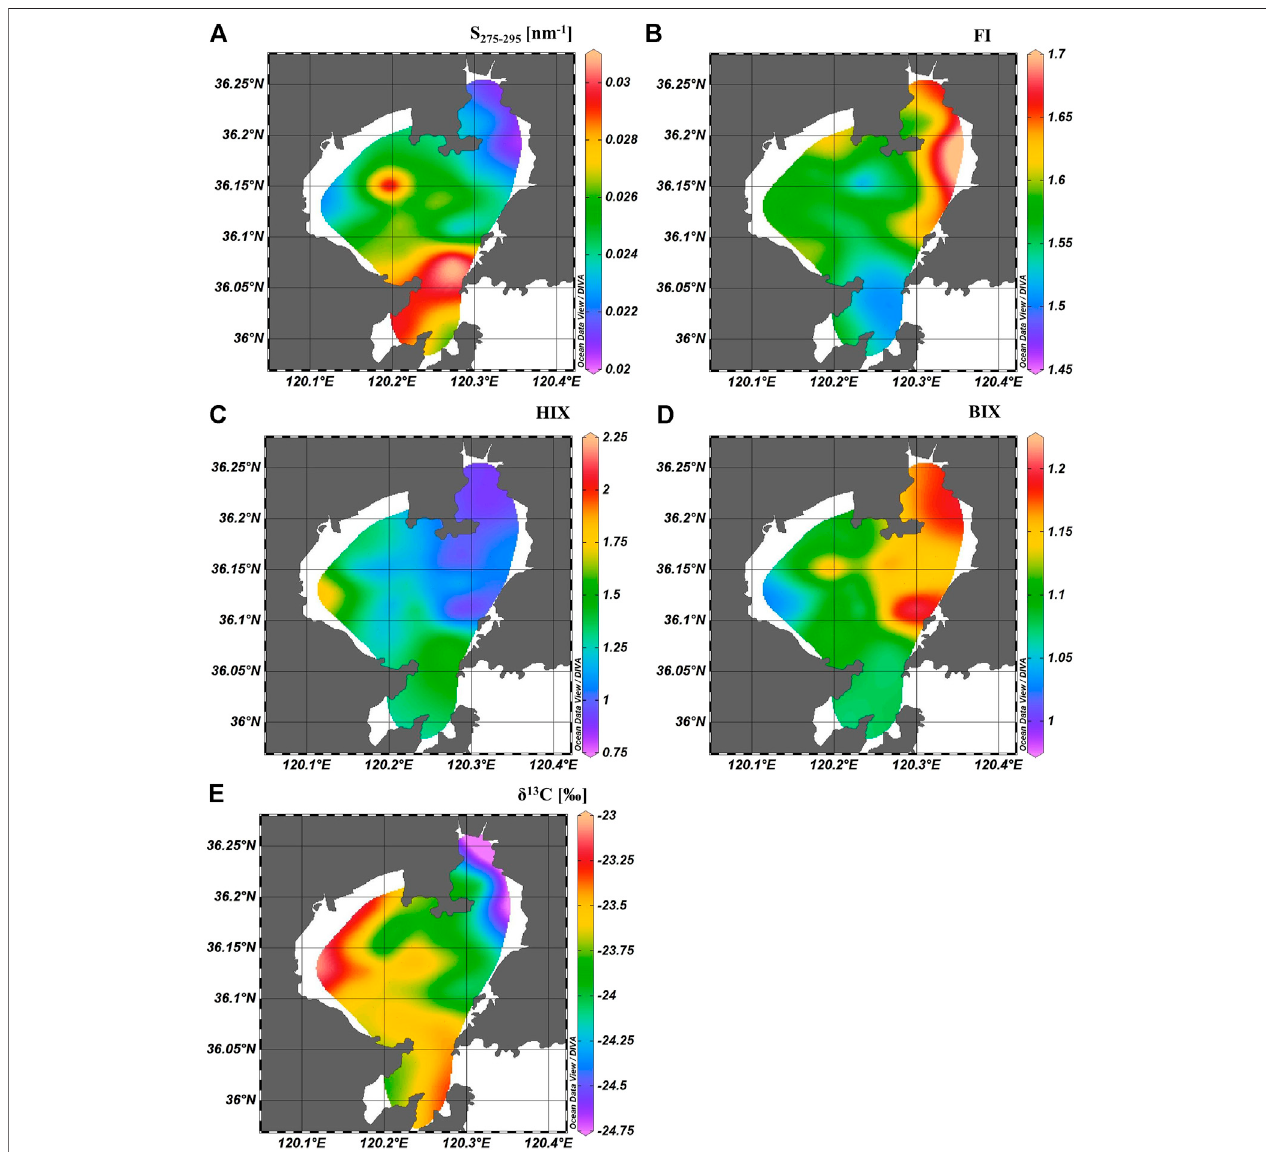
FIGURE7| SurfacedistributionofDOMopticalpropertiesandstablecarbonisotopeinJiaozhouBay. (A) S 275-295 , (B) FI, (C) HIX, (D) BIX,and (E) SPE-DOM δ 13 C. This fi gure was made in ODV using DIVA gridding.